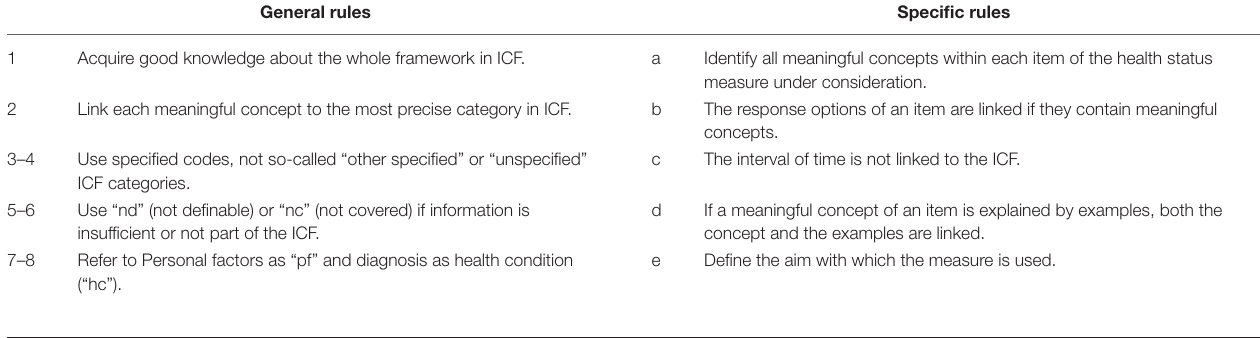
TABLE 2 | Summary of the general and specific linking rules by Cieza et al. (2005, see p. 214–215). General rules